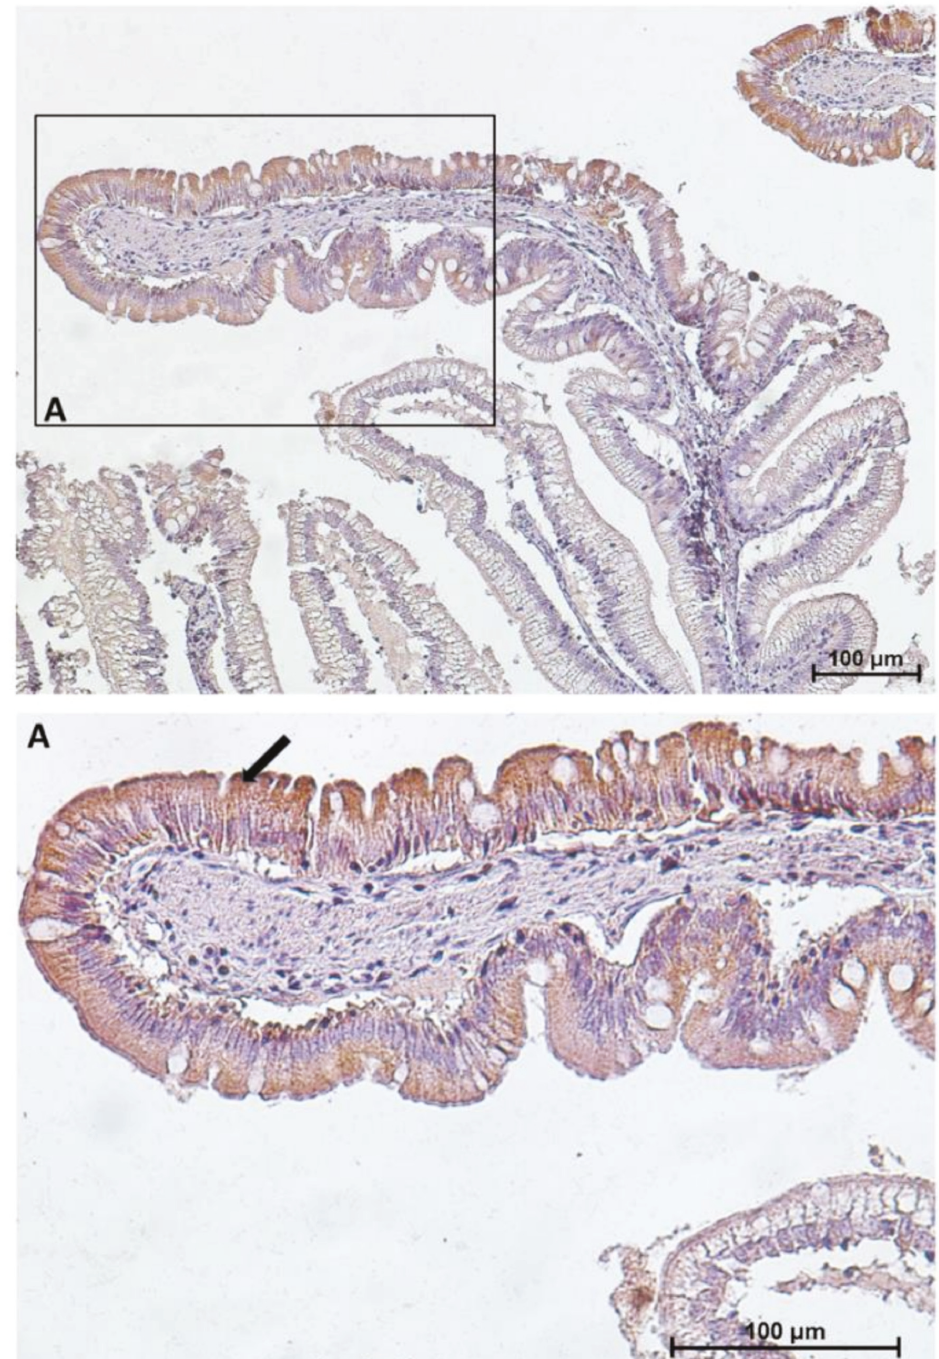
Figure 3. Immunolocalization of peptide transporter 1 (PepT1) in the second segment of the mid-intestine. PepT1 expression is confined to the apical portion of the complex folds where it shows the same intracellular location and signal intensity found in the first segment of the mid-intestine. The lower panel ( A ) shows PepT1 immunolocalization (arrow) at higher magnification.